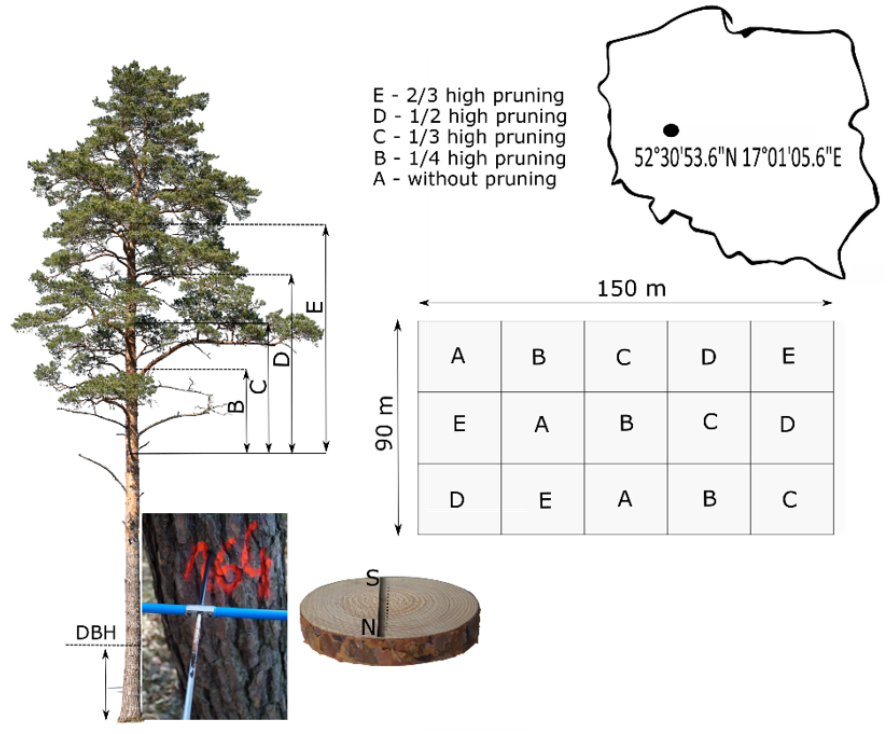
Figure 1. Location of experimental stand in Poland, five treatments levels (A–E), and location of parcels in the triple-replicated pruning